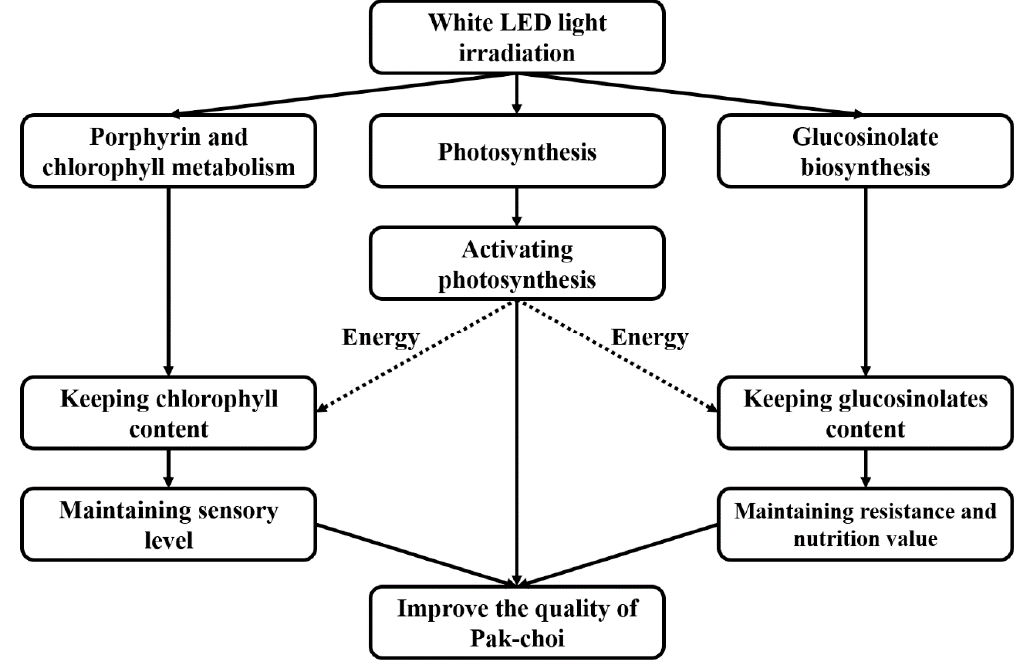
Figure 5. Diagrammatic model of the proposed mechanism responsible for the e ff ect of LED irradiation on the maintenance of postharvest quality of pak-choi. White LED light treatment